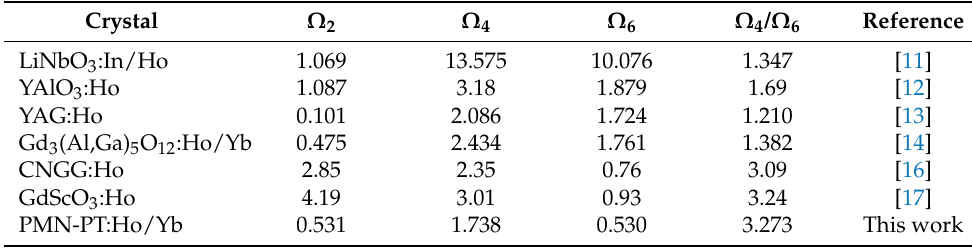
Table 3. The values of Ω t (t = 2, 4, and 6) × 10 − 20 /cm 2 and Ω 4 / Ω 6 of Ho 3+ in laser crystals.